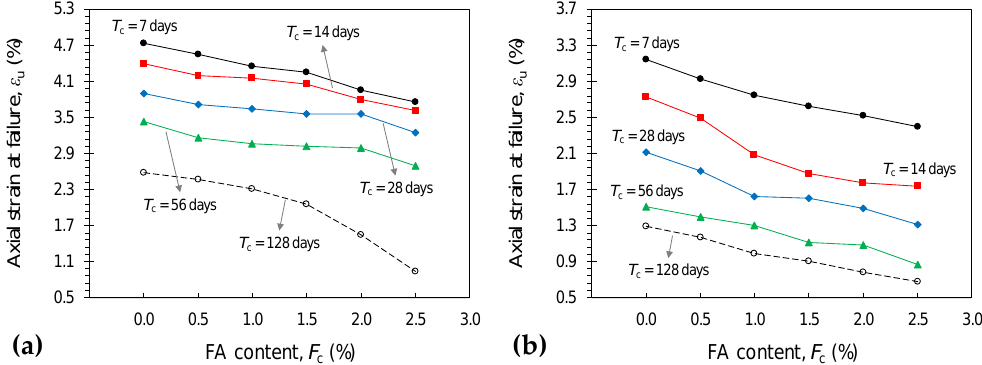
Figure 6. Variations of axial strain at failure ε u against FA content for the samples tested at various curing times: ( a ) M 1.5 F y T z ; ( b ) M 2.5 F y T z ( y = {0, 0.5, 1.0, 1.5, 2.0, 2.5} and z = {7, 14, 28, 56,